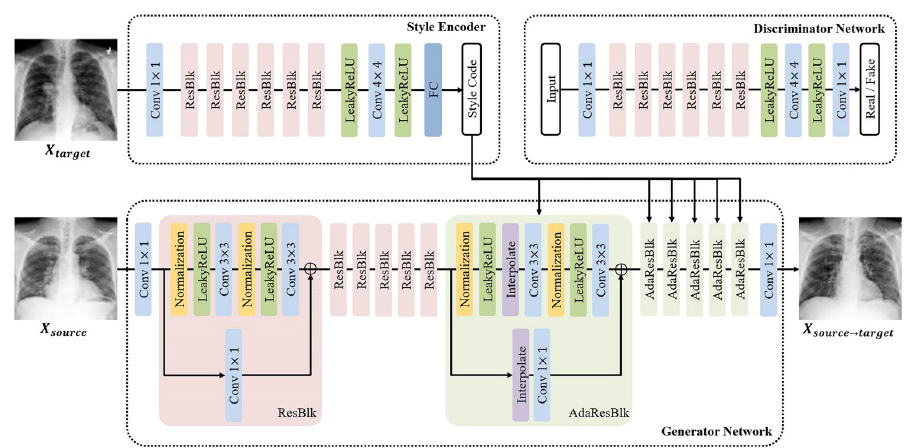
Fig 2. Generative adversarial networks